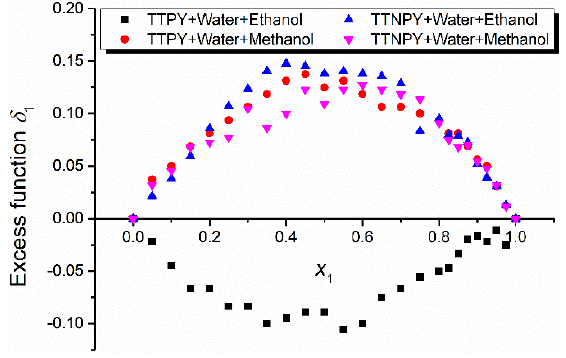
Figure 9. Excess function of the water molecules versus the water content in solution.